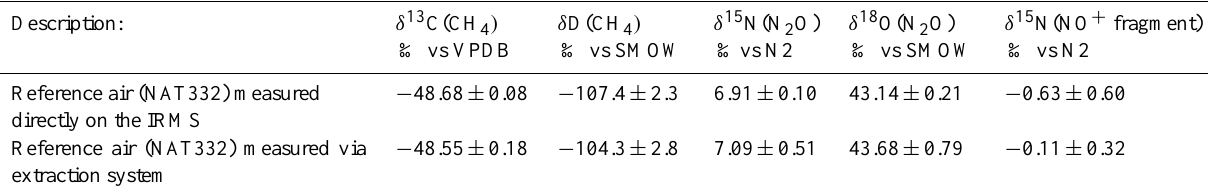
Table 1. Results from tests with the extraction system. Each value represents the mean ± 1 σ standard deviation of > 40 measurements of different amount (20–100ml) of the same reference air (NAT332, 2141ppb CH 4 , 331ppb N 2 O). The first row corresponds to reference air directly measured on the two IRMS systems. The second row corresponds to the measurement of reference air introduced into the SS pot and extracted as an ice core air